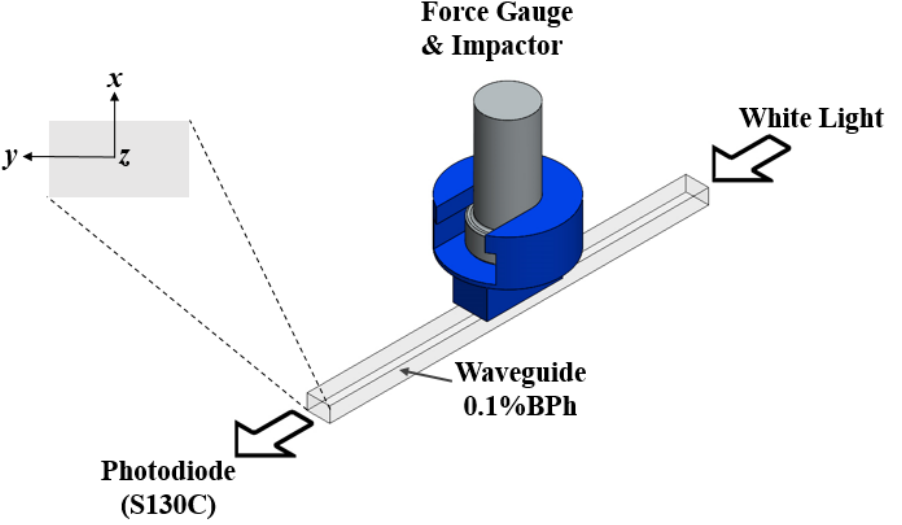
Figure 4. Scheme of the transverse compression test.